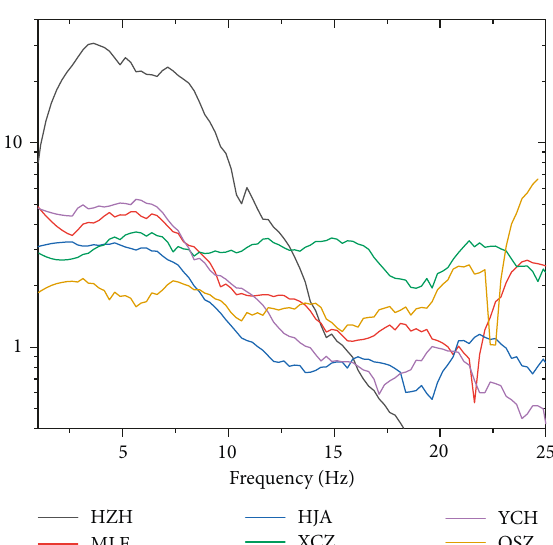
Figure 8: Coda wave.